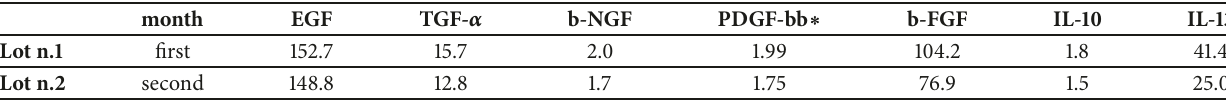
Table 1: Levels of growth factors contained in the CBS eye drops administered to patient n.1, for the first and second month of treatment, respectively.EGF:epidermalgrowthfactor;TGF- 𝛼 :transforminggrowthfactor;b-NGF:basicnervegrowthfactor;PDGF-bb:platelet-derived growth factor; b-FGF: basic fibroblast growth factor; and IL: interleukin. month EGF TGF- 𝛼 b-NGF PDGF-bb ∗